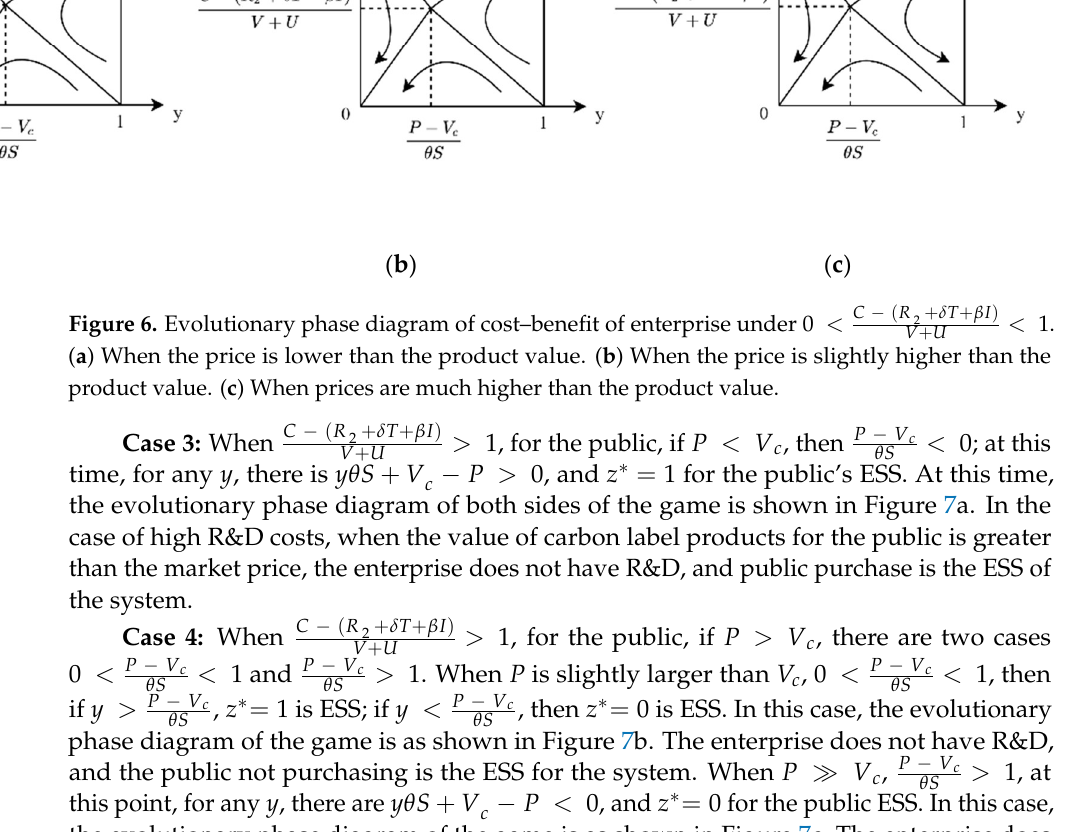
Figure 7. Evolutionary phase diagram of cost–benefit of enterprise under C